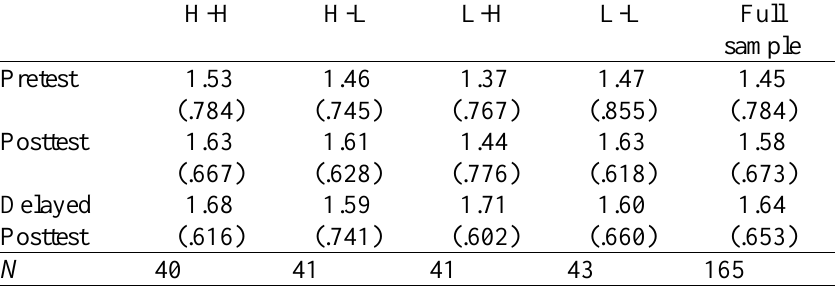
Mean Performance on Transfer Tasks and Standard Deviation Controlling for Pretest